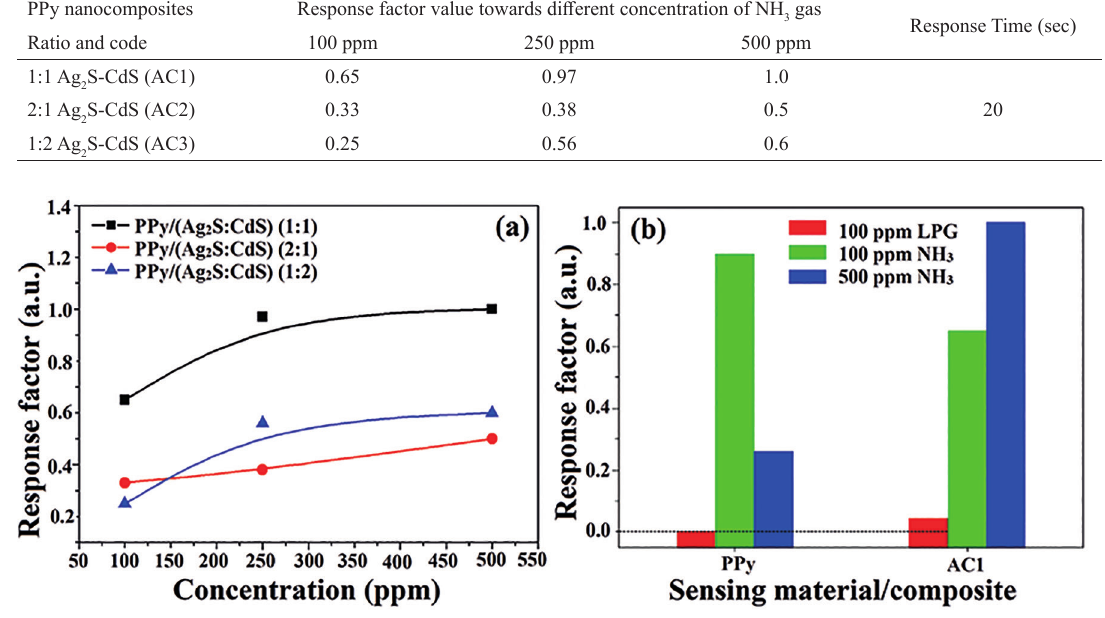
S:CdS) hybrid nanocomposites towards NH 2 S:CdS) (1:1) hybrid nanocomposites. 2